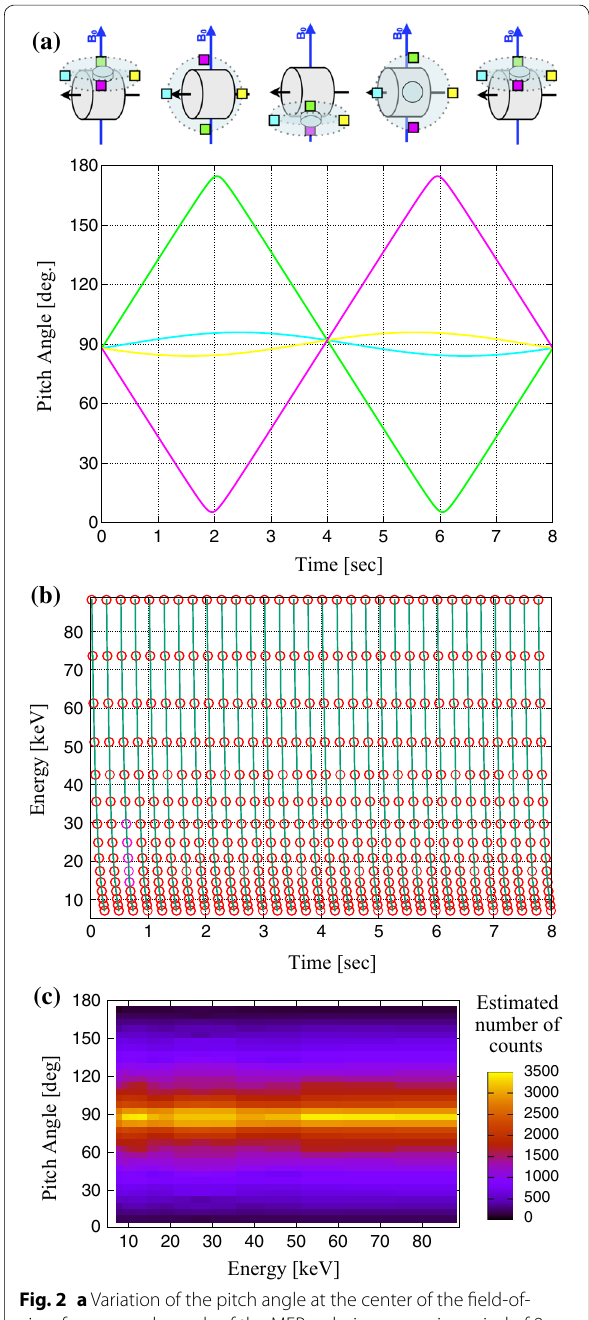
Fig. 2 a Variation of the pitch angle at the center of the field-of- view for sensor channels of the MEP-e during one spin period of 8 s under the assumed condition. Schematics shown in the upper panel represent the FOV of each sensor channel every 2 s, where the color of rectangles corresponds to those of plotted lines. b Energy range measured by MEP-e during one spin period, where 16 energy steps are swept every 0.25 s. c Estimated number of counts measured by the MEP-e during one spin